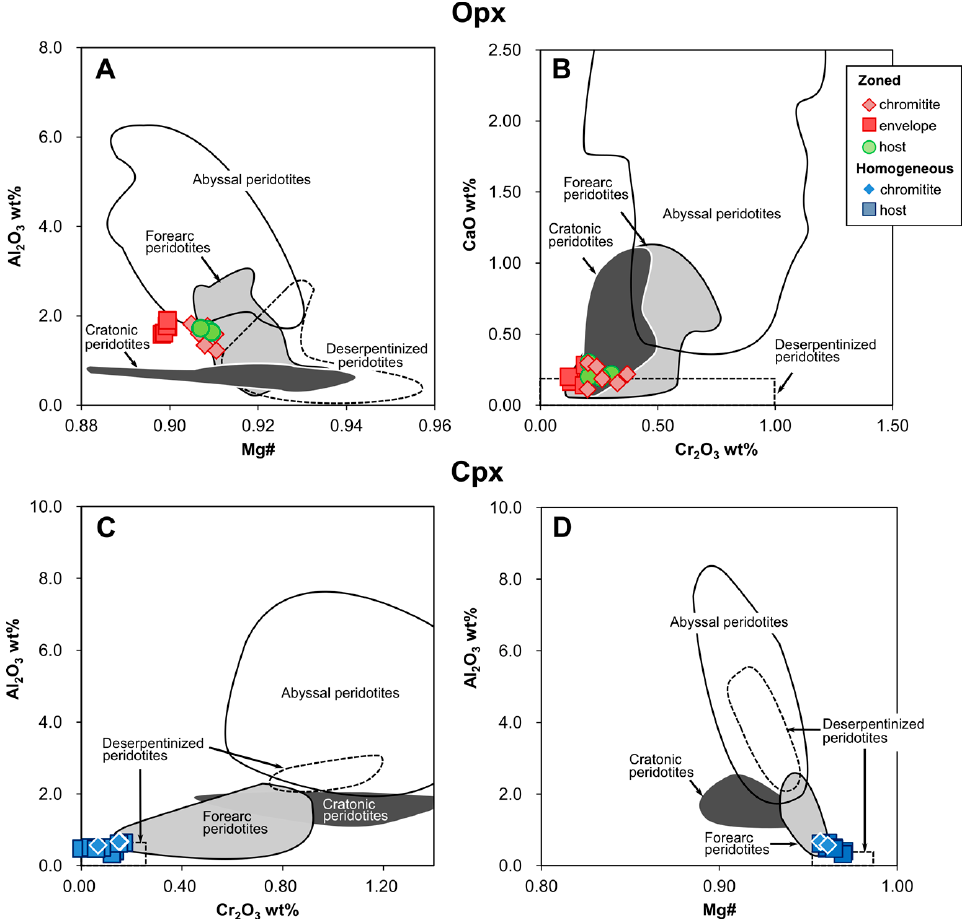
Figure 6. ( A ) Mg# vs. Al 2 O 3 wt % and Cr 2 O 3 wt % vs. CaO wt % plots of orthopyroxenes (Opx); ( B ) Mg# vs. Al 2 O 3 wt % and Cr 2 O 3 wt % vs. Al 2 O 3 wt % of the clinopyroxenes (Cpx). Compositions of metamorphic olivine from the Happo-O’ne peridotite complex [35], Tari-Misaka [36], Ohsa-Yama